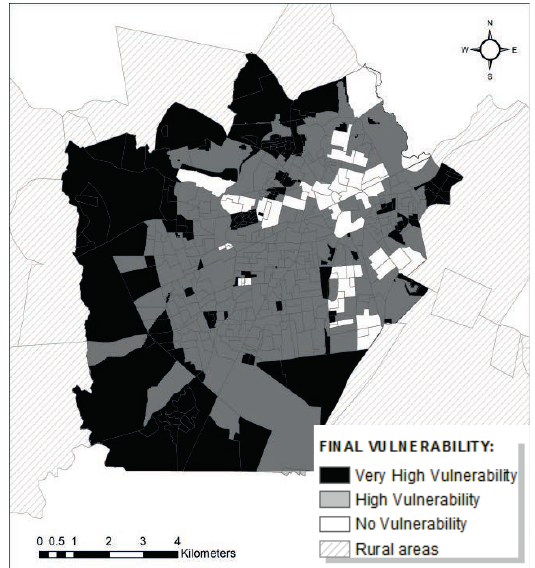
Fig. 6 Final vulnerability